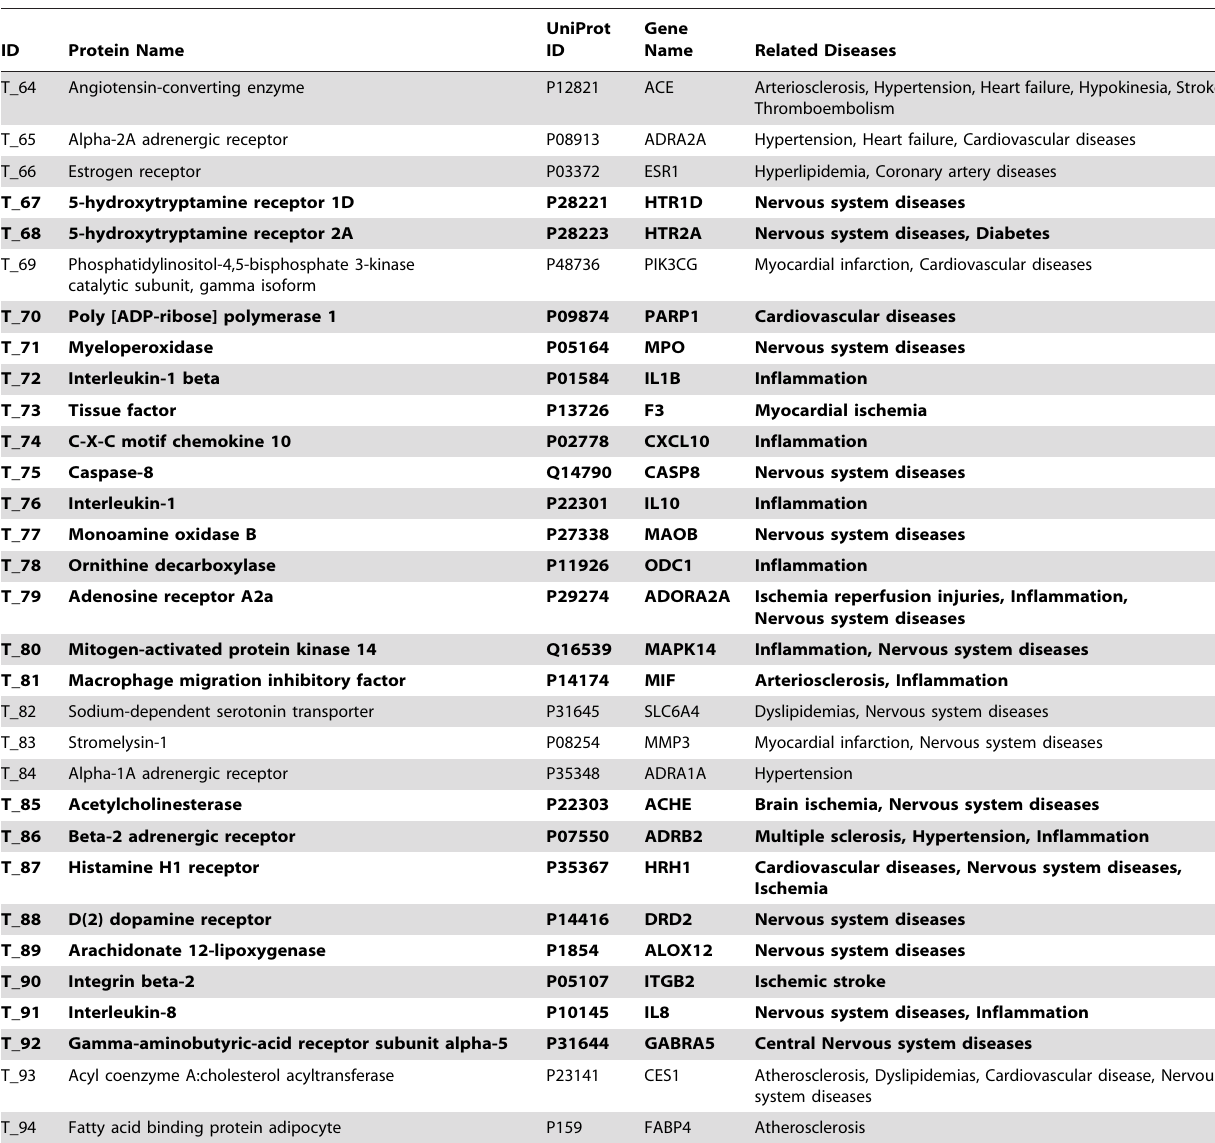
Table 4. The stroke-related targets of herbs and their corresponding diseases (Part